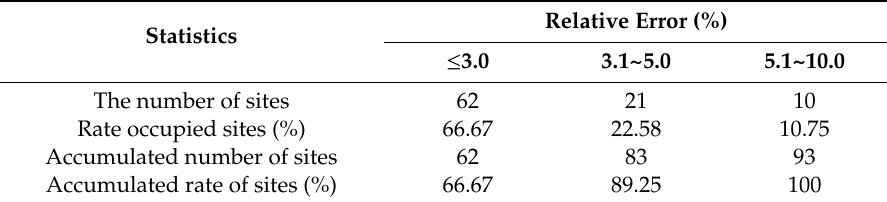
Table 3. Relative errors of calculated runo ff